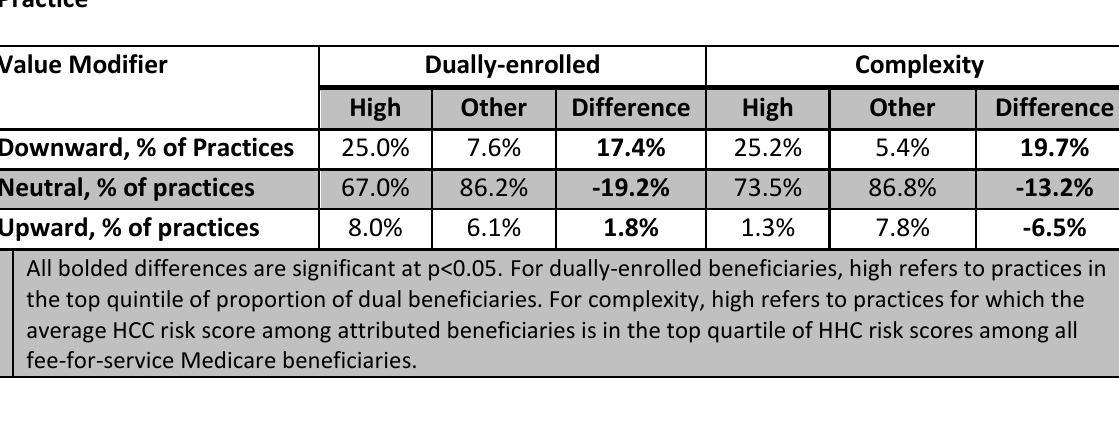
Table 10.14. Summary of Payment Adjustment, by High-Dual or High-Complexity Practice vs. Other